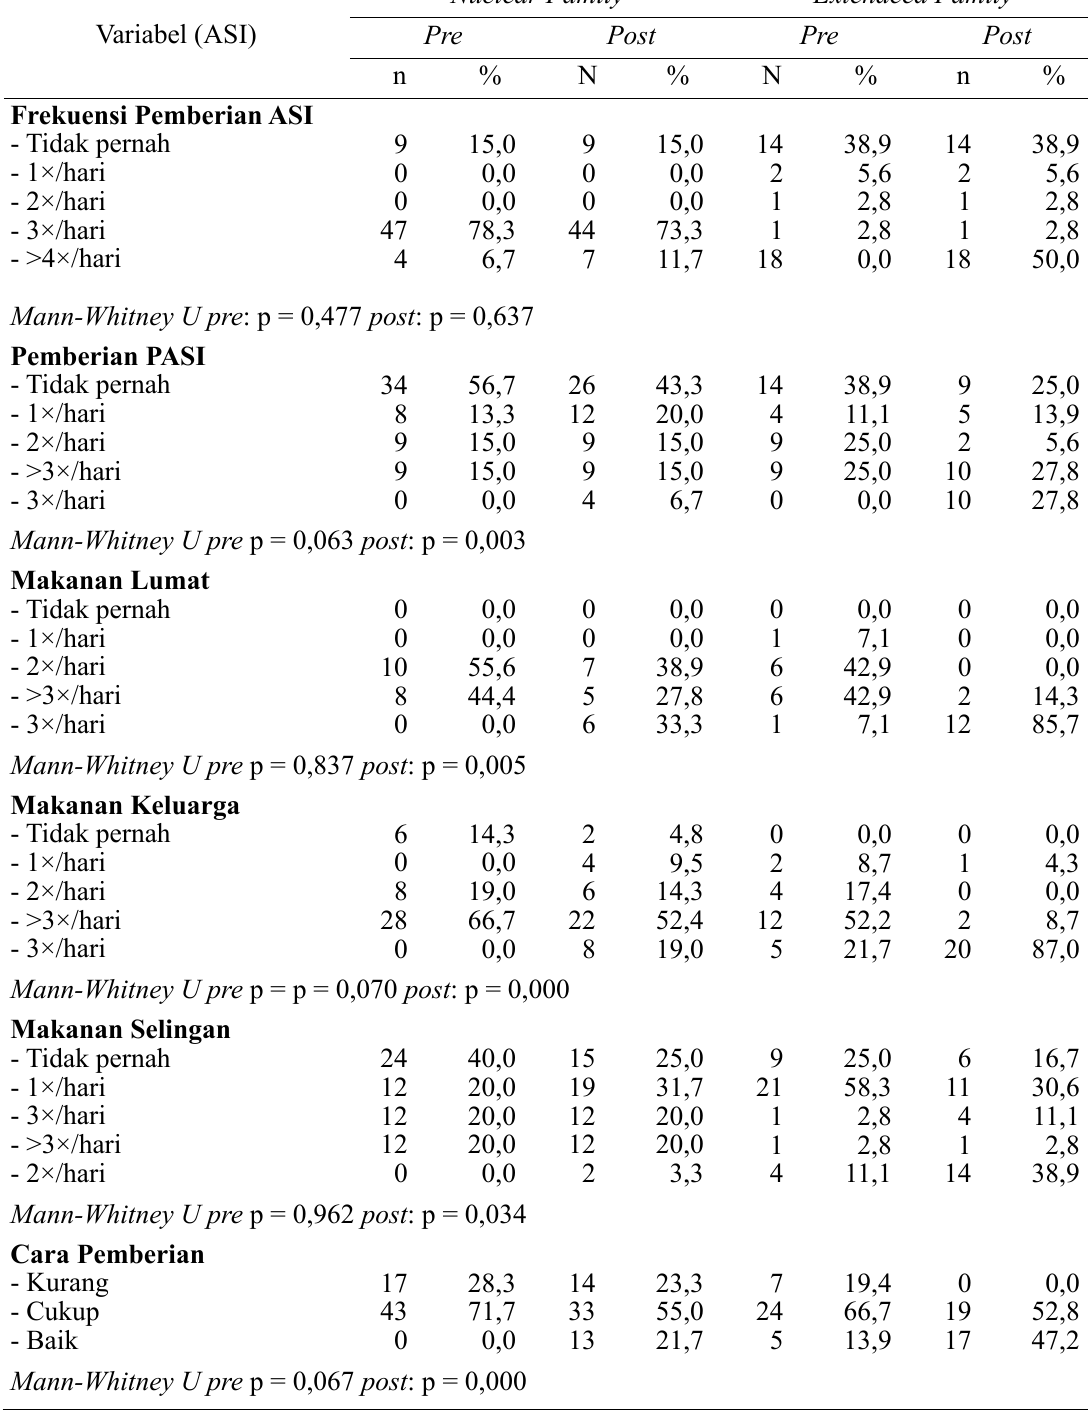
Tabel 1. Praktik pola asuh makan (frekuensi pemberian ASI, pemberian PASI, makanan